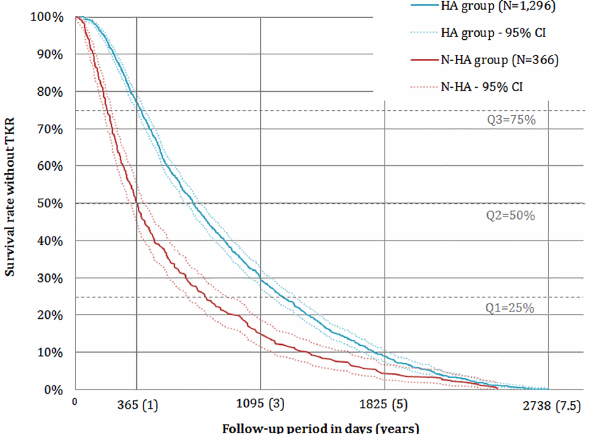
Fig 2. Kaplan-Meier curves of time without TKR for HA and N-HA groups. HA group: patients who receivedat least one IA HA injectionduring their follow-upperiod, N-HA group: patients who receivedonly CS as IA injections,TKR: total knee replacement, IA: intra-articular, HA: hyaluronic acid, CS: